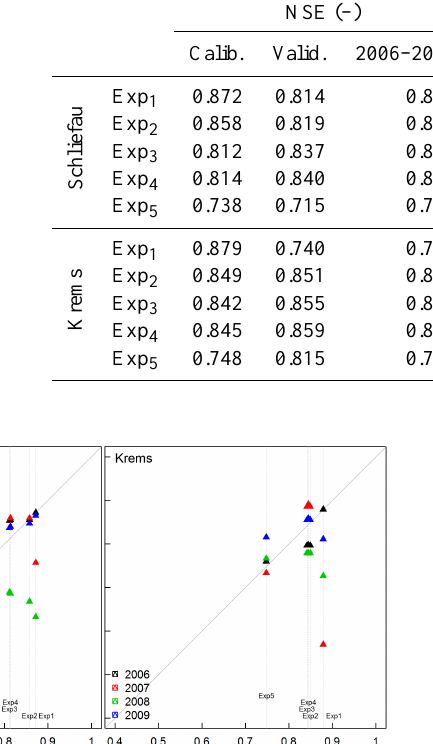
Table 7. Model performance for the different simulation experiments and the two catchments of the forward model, expressed by NSE and the mean bias between simulated and observed runoff in percent of observed runoff for different periods. Only the months June–September are evaluated. NSE (–) mean Bias (%)